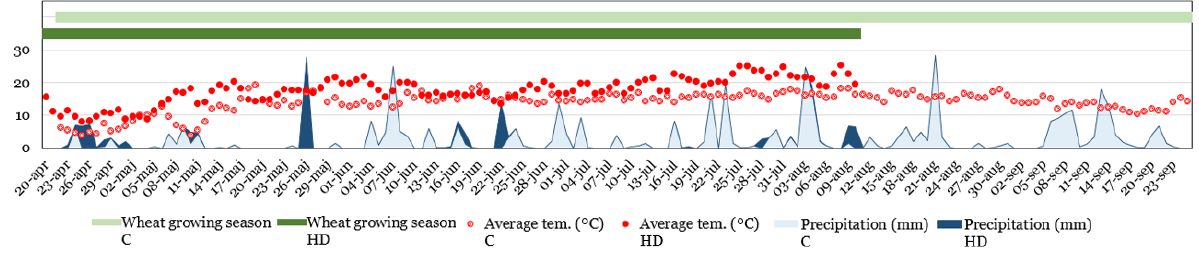
Figure 6. Growing conditions of 56 wheat genotypes grown in two varying environments used in this study; average temperature (°C) and precipitation (mm) during the wheat growing seasons (C—cool, 2017; HT—heat–drought, 2018) expressed as number of days.